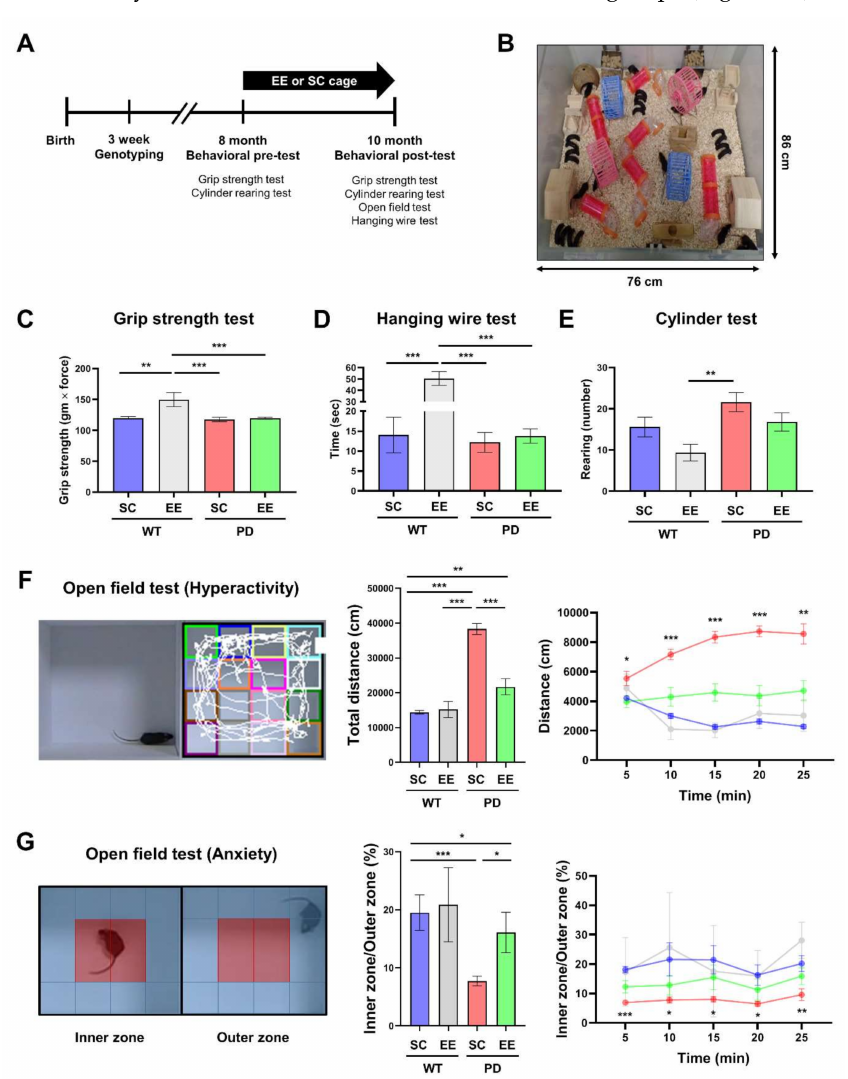
Figure 1. Environmental enrichment (EE) ameliorates hyperactivity and anxiety but not motor function in human A53T(hA53T) alpha-synuclein ( α -Syn) mice. ( A ) Experimental scheme. ( B ) EE (86 × 76 × 31 cm 3 ). ( C ) The grip strength test (wild-type (WT)- standard cages (SC), n = 5; WT-EE, n = 10; Parkinson’s disease (PD)-SC, n = 10; PD-EE, n = 10). ( D ) The hanging wire test (WT-SC, n = 5; WT-EE, n = 5; PD-SC, n = 10; PD-EE, n = 10). ( E ) The cylinder test (WT-SC, n = 10; WT-EE, n = 8; PD-SC, n = 10; PD-EE, n = 16). ( F , G ) Open field test conducted in a square area (30 × 30 × 30 cm 3 ). The floor was divided into 16 sectors. The four red sectors represent the inner zone, and the 12 blue sectors represent the outer zone. ( F ) Open field test for hyperactivity (WT-SC, n = 12; WT-EE, n = 3; PD-SC, n = 15; PD-EE, n = 12). ( G ) Open field test for anxiety (WT-SC, n = 10; WT-EE, n = 3; PD-SC, n = 12; PD-EE, n = 11. The values represent the mean ± SEM. * p < 0.05, ** p < 0.01, and *** p <